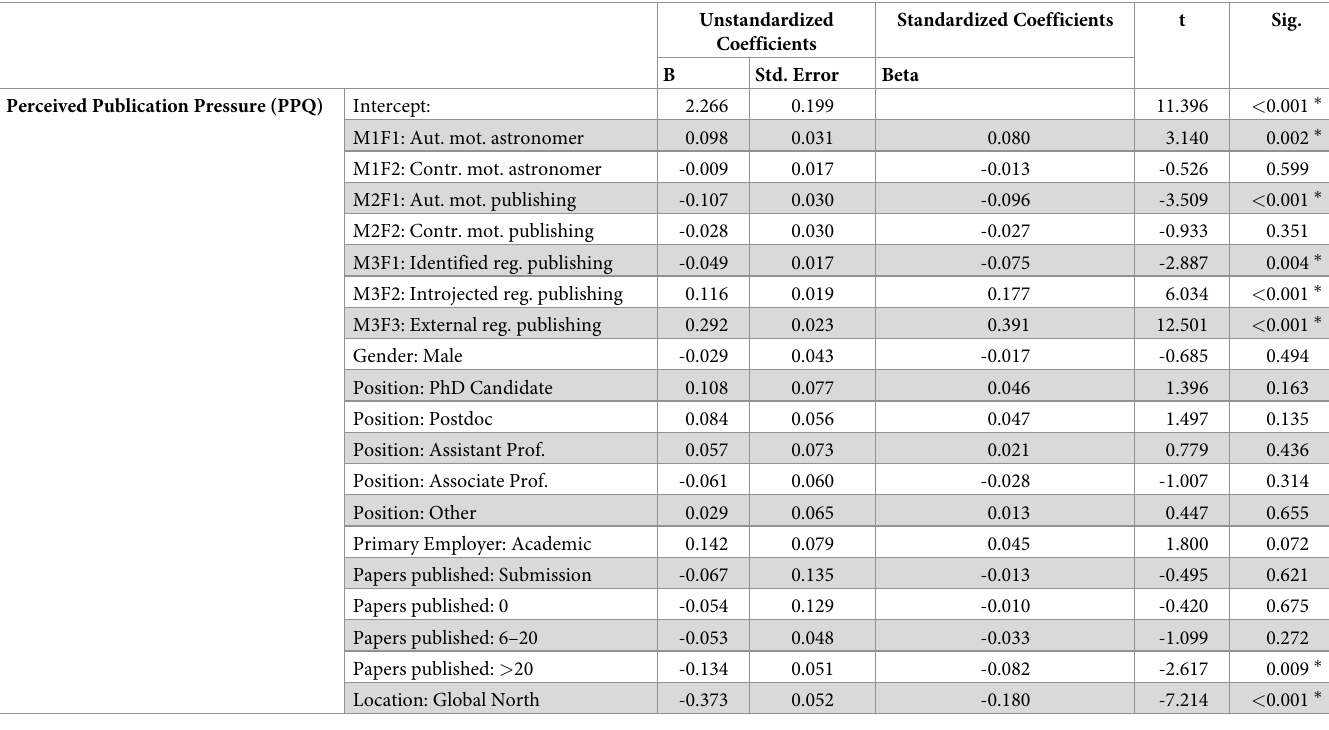
Table 6. Regression model of DV = Perceived Publication Pressure; regressed onto the seven motivational factors and the control variables.